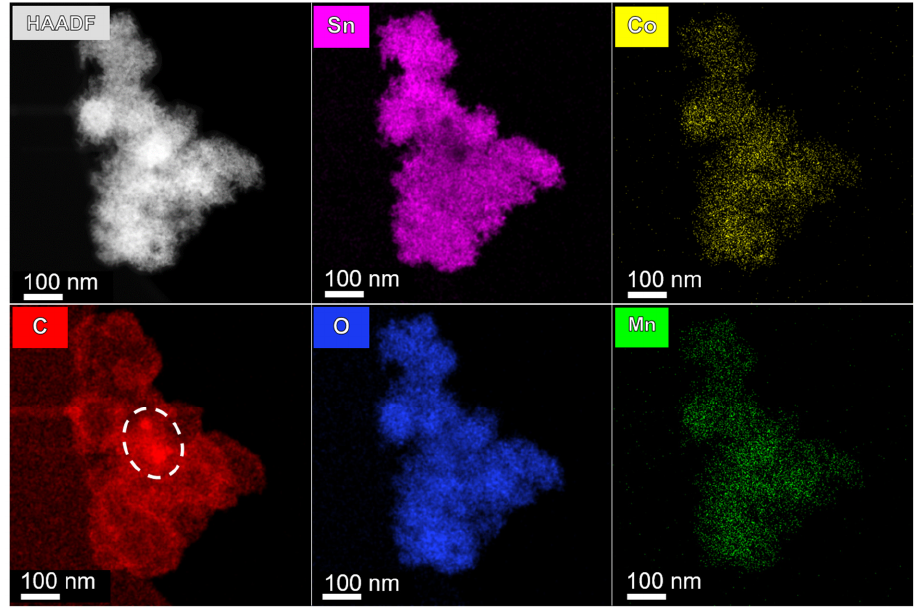
Figure 2. EDX analysis of SCMO@C with the corresponding high-angle annular dark-field (HAADF) image shown in the top left and the elemental mapping for Sn in pink, Co in yellow, C in red (the cavity filled with carbon is highlighted by a white circle), O in blue, and Mn in green. Thereafter, XRD data were collected and Rietveld refinements undertaken. The two fitted XRD patterns for SCMO and SCMO@C are displayed in Figure 3. The starting struc- tural model for the refinement is presented in Table S1 and an overview of the results is provided in Table S2. For the refinement, both TMs were assumed to dope the SnO 2 struc- ture and replace the Sn atoms in the 2a Wyckoff site. Nonetheless, this assumption cannot be confirmed by the Rietveld analysis due to the small concentration of the two dopants, requiring additional insights from the X-ray Absorption Spectroscopy (XAS) investiga- tion, which will be discussed later. Generally, both XRD patterns are characterized by ra- ther broad reflections, indicating the nanocrystalline nature of the two materials. Accord- ing to the fitting, the domain (i.e., crystallite) size was in the range from 6 (equatorial) to 11 (axial) nm (see Table S2), which is in fairly good agreement with the TEM data (Figure 1), confirming the observation of single-crystalline, elongated nanoparticles. Besides, the good overlap of the structural parameters, atomic positions, and atomic occupancies ren- ders the two materials essentially equivalent.